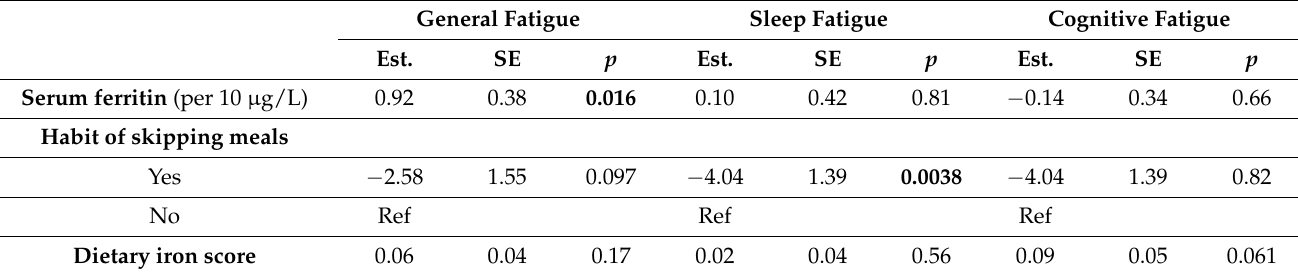
Table 5. Factors associated with fatigue